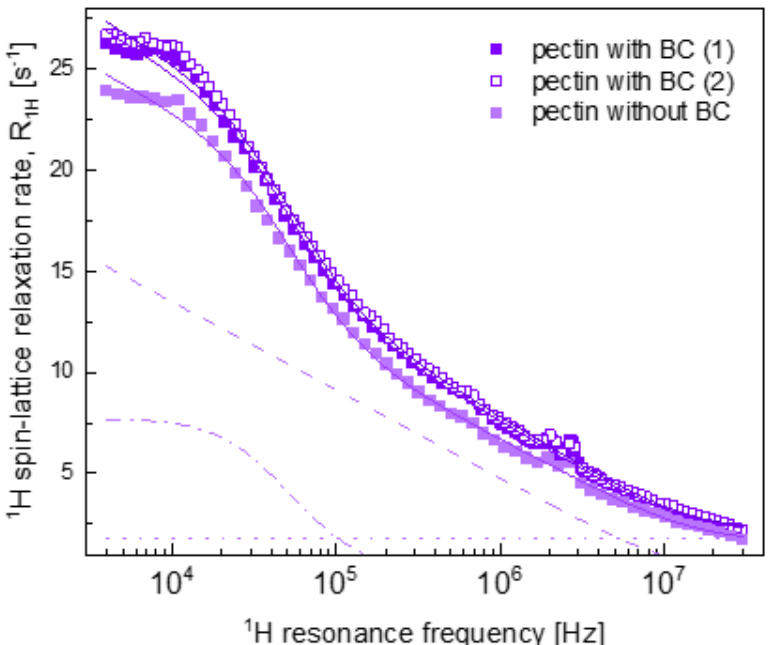
Figure 3. 1 H spin ‐ lattice relaxation data for pectin hydrogels with and without BC. Solid and double solid violet lines—Figure 1. of the data for pectin with BC (1) and (2) data sets, respectively, solid light violet line—fit ( R 1, H ( ω H )) of the data for pectin without BC decomposed into 𝑅 (cid:2869),(cid:3009)(cid:3030)(cid:3042)(cid:3041)(cid:3033),(cid:3036)(cid:3041)(cid:3047)(cid:3032)(cid:3045) (cid:4666)𝜔 (cid:3009) (cid:4667) —dashed line, 𝑅 (cid:2869),(cid:3009)(cid:3030)(cid:3042)(cid:3041)(cid:3033),(cid:3036)(cid:3041)(cid:3047)(cid:3045)(cid:3028) (cid:4666)𝜔 (cid:3009) (cid:4667) —dashed–dotted line and 𝐴 —dotted line.